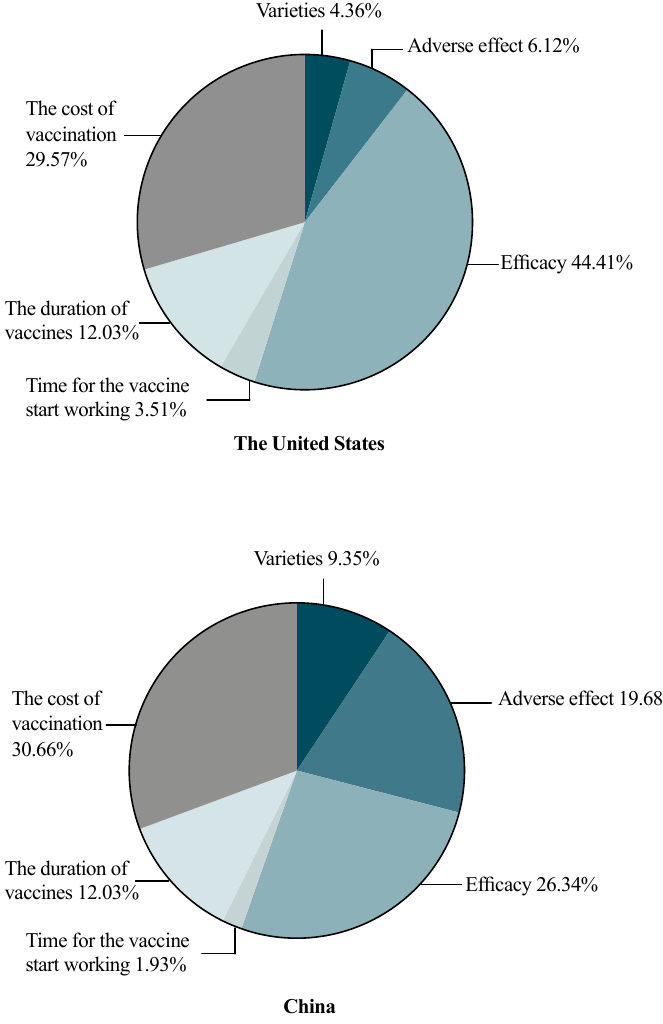
Figure 3. The relative importance of COVID-19 vaccine attributes: comparison between respondents from the United States and China.